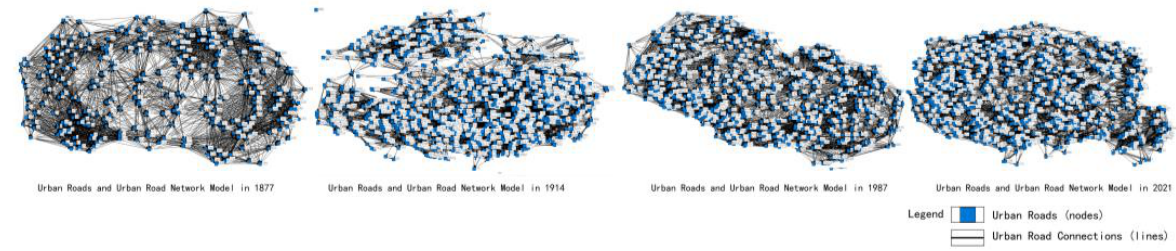
Figure 4. Urban Roads and Urban Road Network Model in Various Periods.